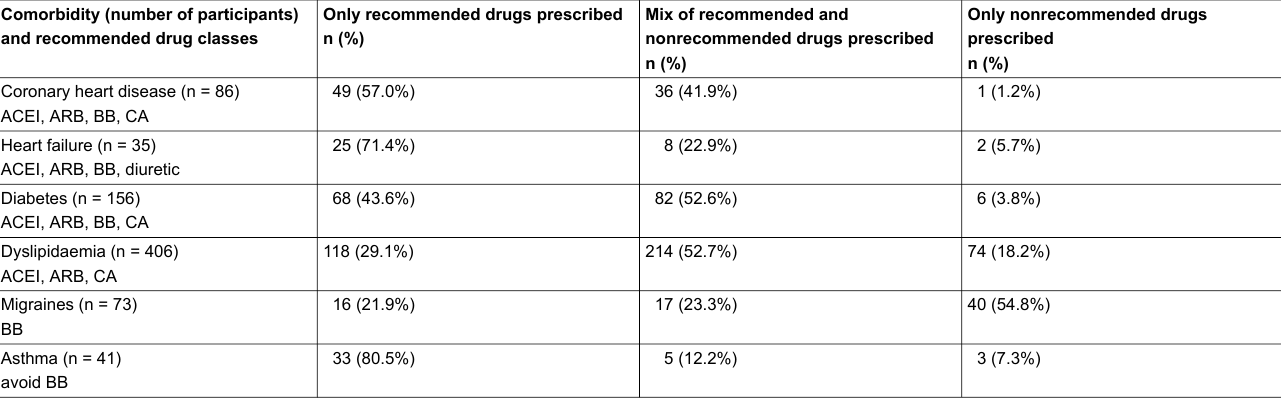
Table 3: Comorbidity-specific guideline adherence and nonadherence in those with drug treated, doctor-diagnosed hypertension (n = 975). Comorbidity (number of participants) Only recommended drugs prescribed and recommended drug classes n (%) n